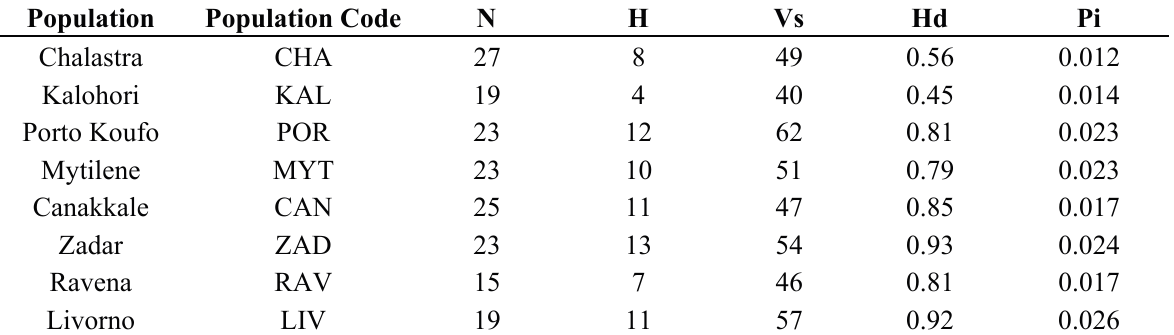
Table 2. A three-digit code, sample size (N), number of haplotypes (H), variable sites (Vs), haplotype diversity (Hd) and nucleotide diversity (Pi) for each population